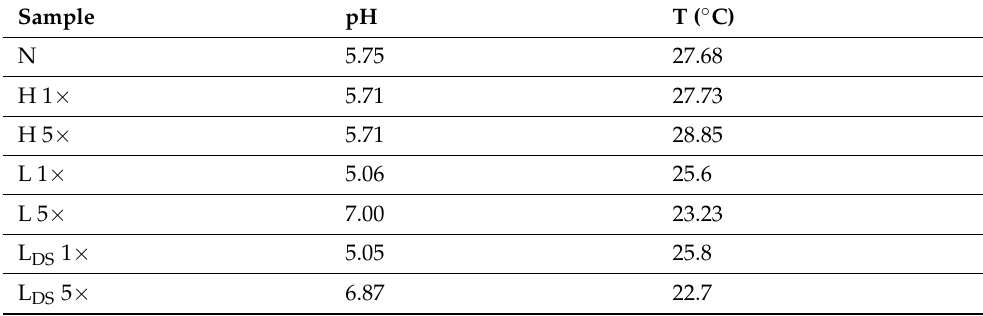
Table 7. pH value of the back surface of medical masks before and after washing.